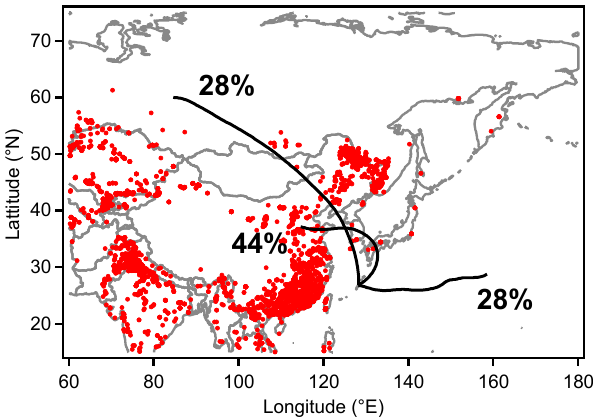
Figure 7. Air mass origins for the event of elevated ratio of lev- oglucosan to mannosan (L / M) on 27 October–3 November 2009. Clusters of 5-day backward trajectories arriving at 500ma.g.l. at Cape Hedo, Okinawa, are given. The numbers in the panel indicate the percentages of hourly trajectories with such origins. Fire spots in East Asia during 22 October–3 November 2009 are also